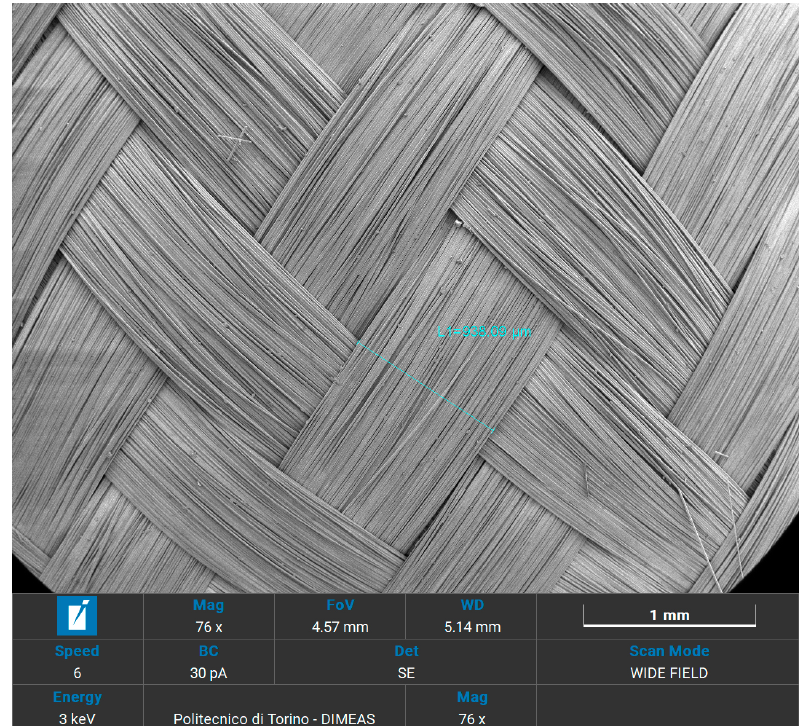
Figure 11. Virgin Basalt Fiber Woven